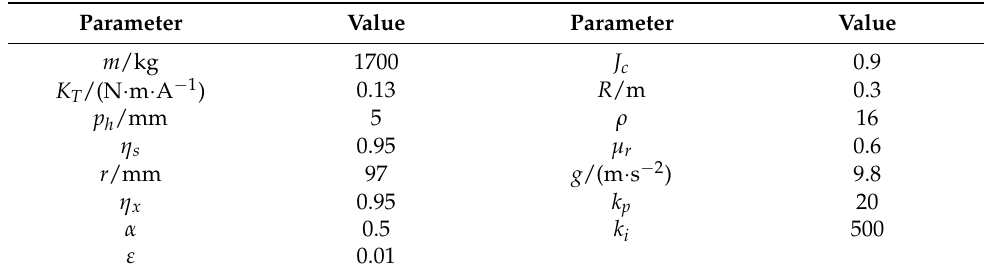
Table 7. The simulation